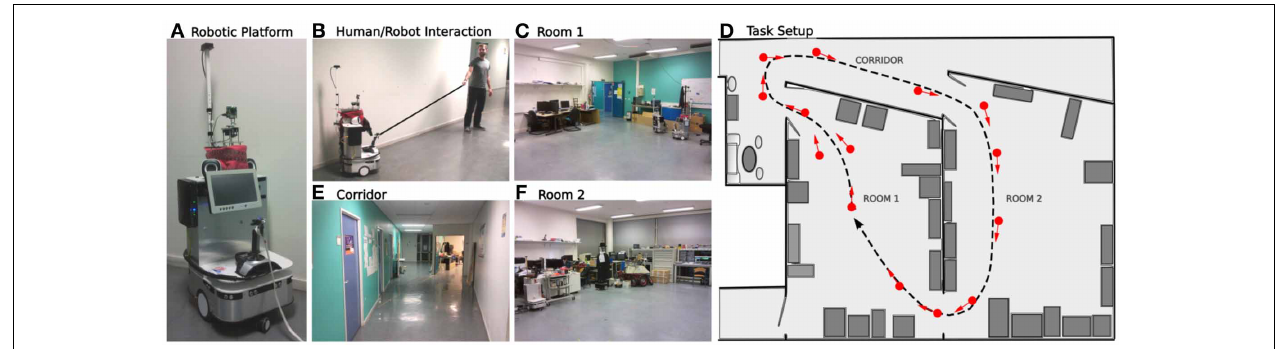
FIGURE 7 | Experimental setup in our laboratory. (A) Robotic platform used (Robulab from Robosoft). (B) Supervised learning: the teacher uses a leash to pull the robot in the desired direction. The robot learns the path autonomously. (C–E) The 3 different rooms of the experiment.